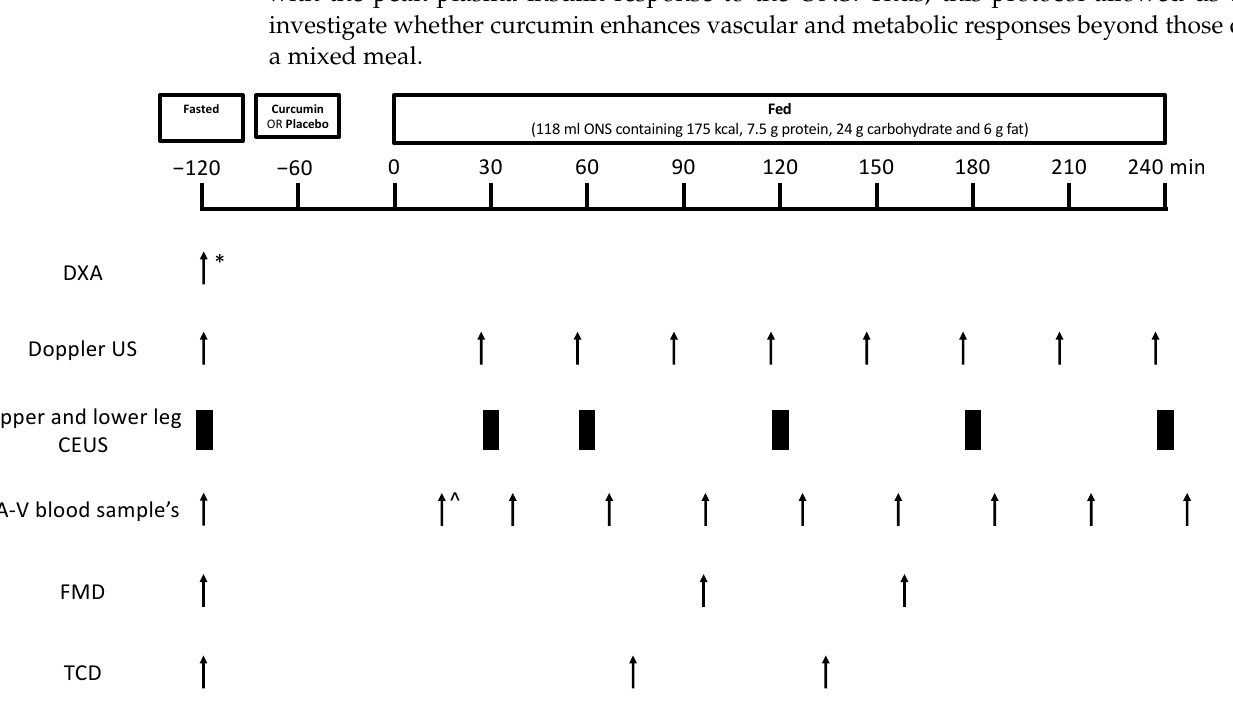
Figure 1. Study protocol schematic. The * indicates assessment was carried out during study visit 1 only, ^ indicates that the first blood draw occurred 15 min after the oral nutritional supplement. Arrows and black rectangles indicate when assessments were carried out. Abbreviations: A-V, arteriovenous; CEUS, contrast-enhanced ultrasound; DXA, dual-energy X-ray absorptiometry; FMD, flow-mediated dilation; TCD, transcranial Doppler; US, ultrasound.